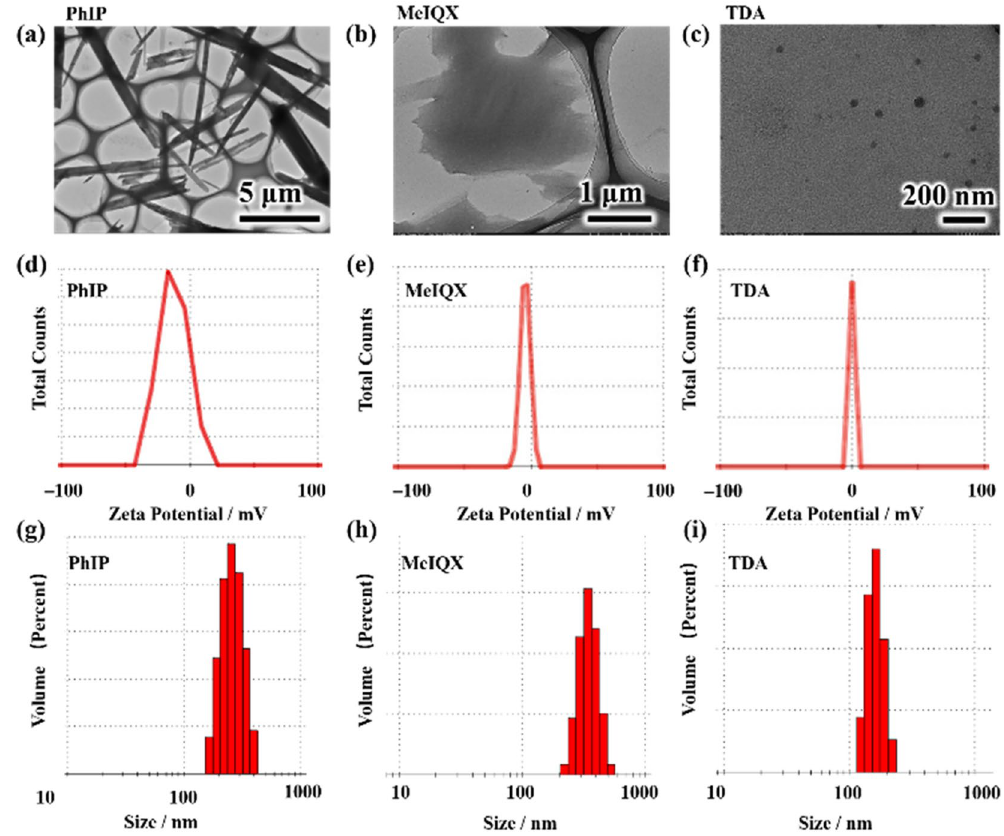
Figure 2. TEM ( a – c ) images, Zeta potentials ( d – f ) and ( g – i ) Dynamic Light Scattering (DLS) size distribution of PhIP, MeIQx and TDA aerosol particles,